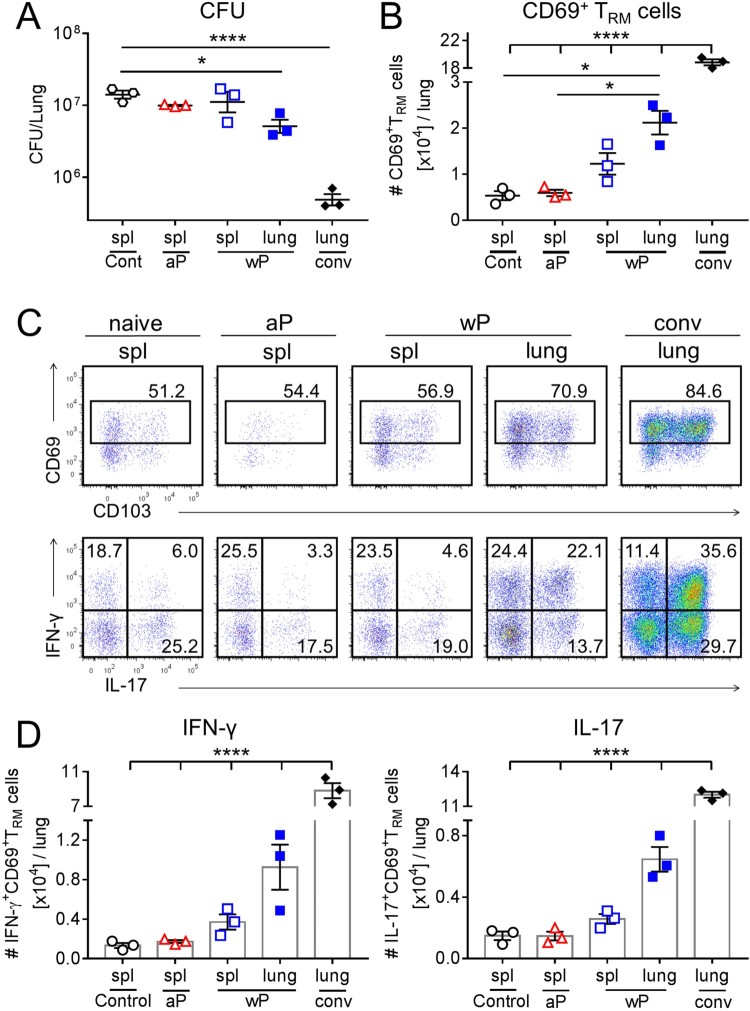
CD69+CD4+ TRM cells that secrete IFN-γ and IL-17 accumulate in the lungs and reduce bacterial burden in naïve recipient mice after transfer from wP-immunized mice. C57BL/6 mice were immunized with aP and wP vaccines at 6 and 2 weeks or were challenged with B. pertussis 7 weeks before euthanasia. Anti-CD45 Ab was administered i.v. 10 min. prior to euthanasia to discriminate circulating from lung resident leukocytes. CD45iv–CD4+ T cells were purified from the lungs of wP-immunized or convalescent mice and CD4+ T cells from the spleens of aP- or wP-immunized or naive control mice. 2 × 105 lung and 4 × 105 spleen CD4 T cells were adoptively transferred to naïve irradiated mice one day prior to aerosol challenged with B. pertussis. (a) CFUs in the lungs were enumerated at day 13 post challenge. Results shown are mean ± SEM (n = 3 mice). *p < .05; ****p < .0001 by one-way ANOVA with the Tukey’s post-test. (b) Total number of CD69+CD4+ TRM cells in the lungs at day 13 post challenge (c) Flow cytometry analysis showing representative plots of CD69 and CD103 expression on CD45iv–CD44+CD62L–CD4+ T cells and IFN-γ and IL-17 secretion by CD45iv–CD44+CD62L–CD69+CD4+ TRM cells and (d) total number of IFN-γ- and IL-17-secreting CD69+CD4+ TRM cells in the lungs at day 13 post challenge. Results shown are mean ± SEM (n = 3 mice). ****p < .0001 by one-way ANOVA with the Tukey’s post-test.